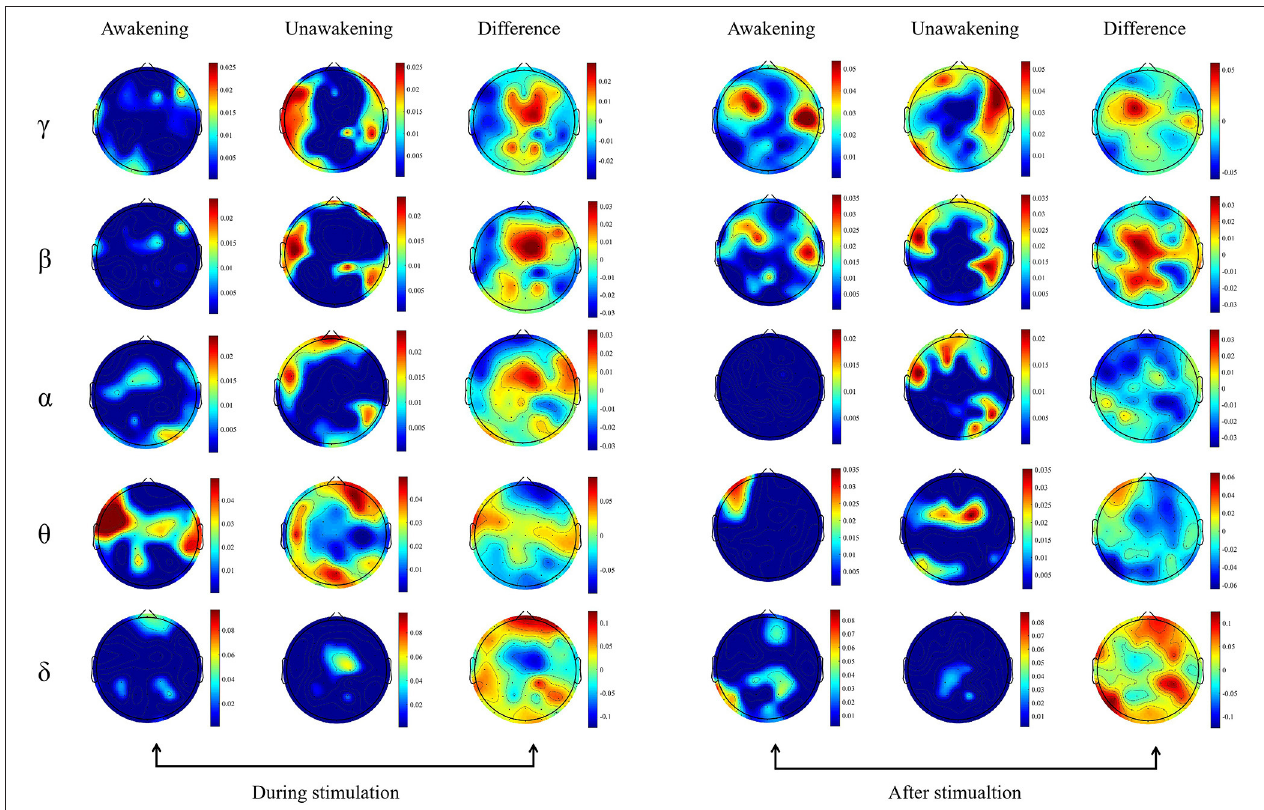
FIGURE 3 | Topography based on relative spectral power. The spectral power between the awakening and unawakening patients were compared in different frequency bands during and after stimulation separately. The first column includes the results of comparisons before and during stimulation in the awakening group, the second column includes the results of comparisons before and during stimulation in the unawakening group, and the third column includes the difference between the awakening and unawakening groups. Similarly, the fourth, fifth and sixth columns are the results of comparisons after stimulation and between stimulation in the awakening group and unawakening group, respectively (fourth and fifth columns) and their difference (sixth column). The color bar represents the actual value of the relative power spectrum.